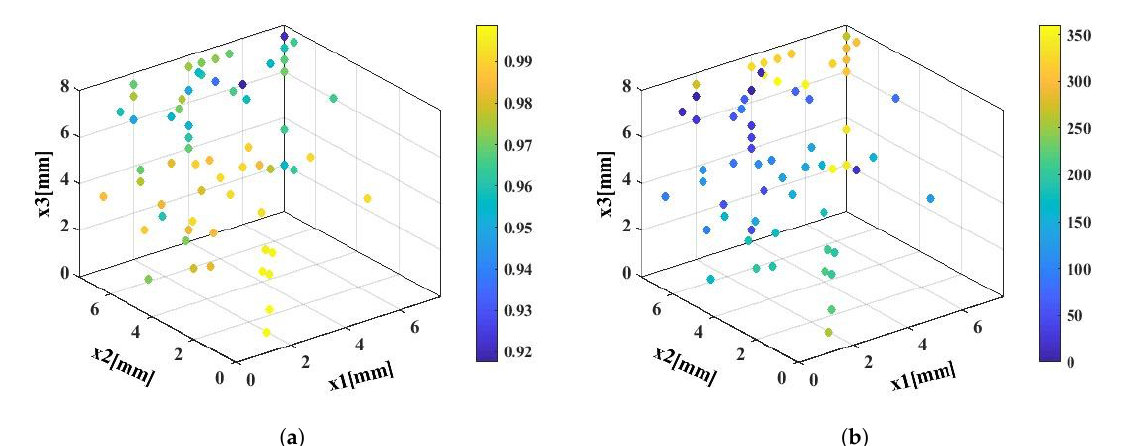
Figure 2. Variation in ( a ) transmission magnitude plots, ( b ) transmission phase (degrees) plots against the relative cubes size for x1, x2 and x3 for four-layer cube arrangement.